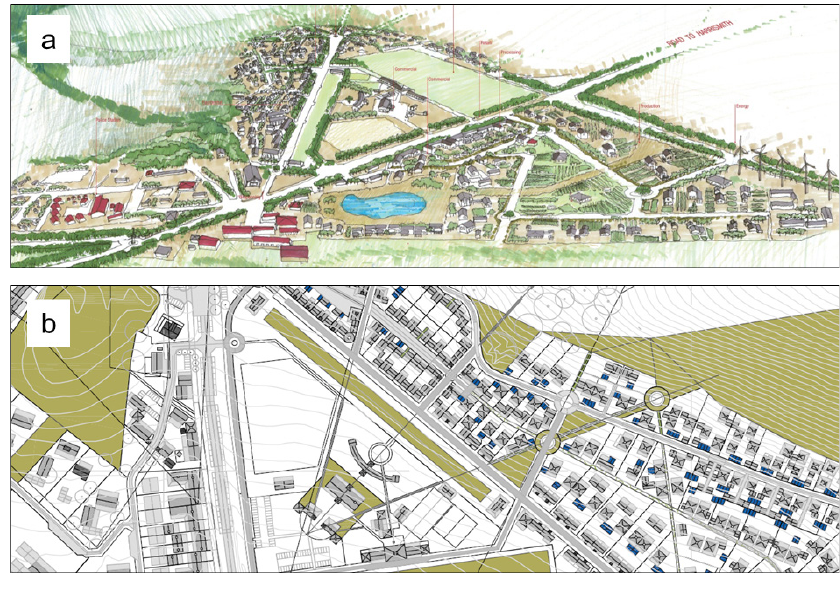
Figure 12: (a) “2050 vision”; (b) exhaustive master plan